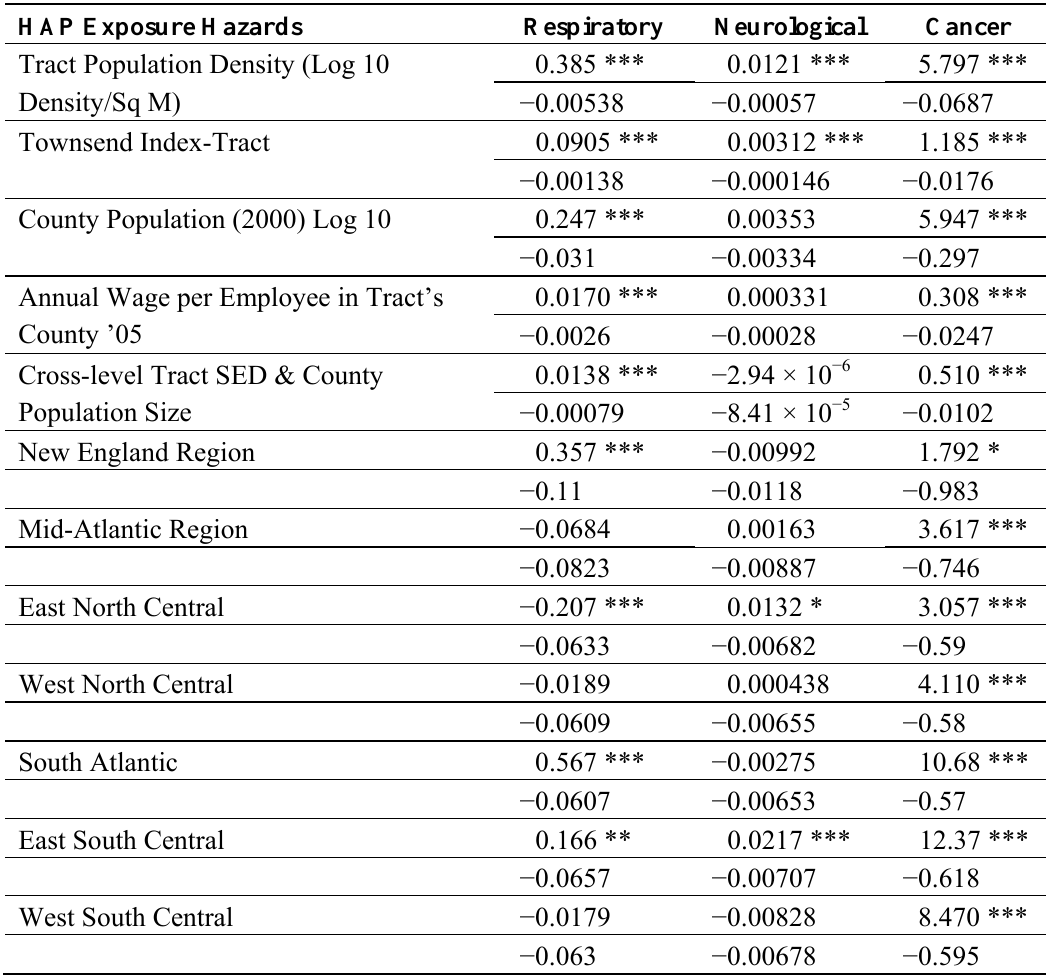
Table 3. Multilevel Models of SED & HAP Exposure Hazard After Adjustment for County Population Size and Economic Activity and Tract Population Density: Respiratory, Neurological, and Cancer Exposure Hazards,